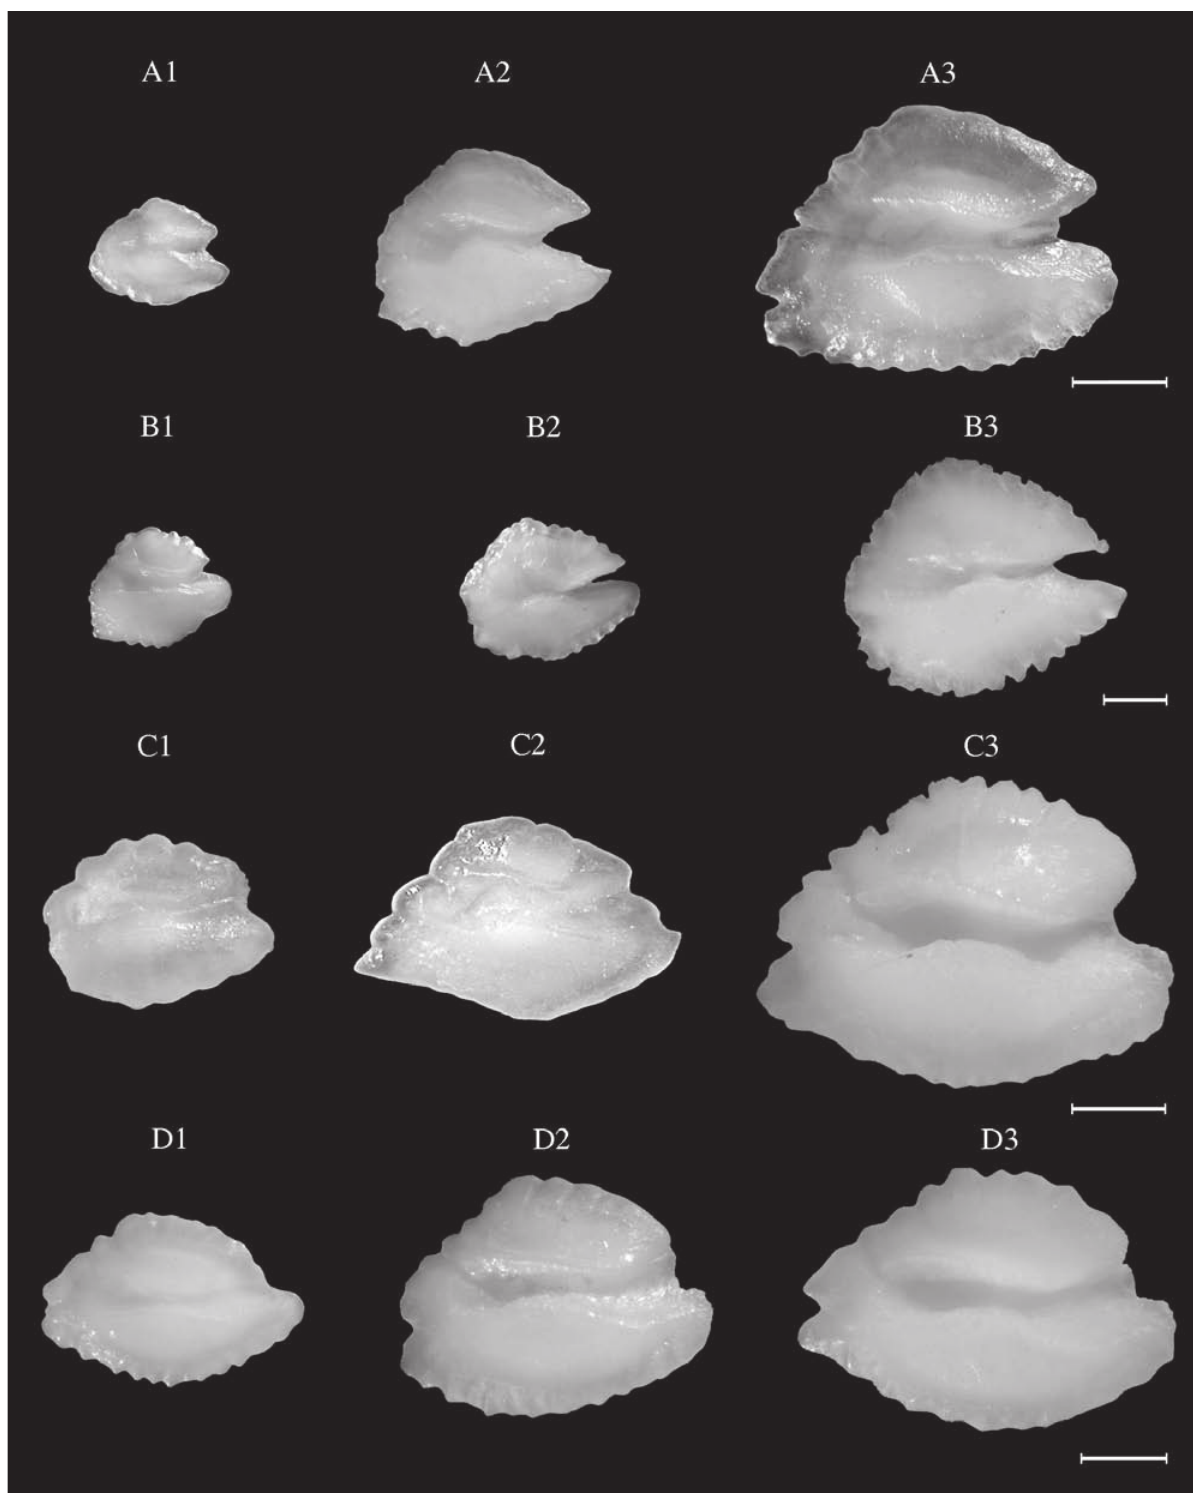
Fig. 44. – Chelidonichthys gurnardus . TL: A1, 8.0 cm (WM); A2, 16.3 cm (NEA); A3, 25.0 cm (WM). Chelidonichthys lucernus . TL: B1, 12.5 cm (WM); B2, 17.0 cm (WM); B3, 32.2 cm (NEA). Lepidotrigla cavillone . TL: C1, 7.5 cm (WM); C2, 11.5 cm (WM); C3, 15.6 cm (NEA). Lepidotrigla dieuzeidei (NEA). TL: D1, 9.6 cm; D2, 13.5 cm; D3, 15.9 cm. Scale bar = 1